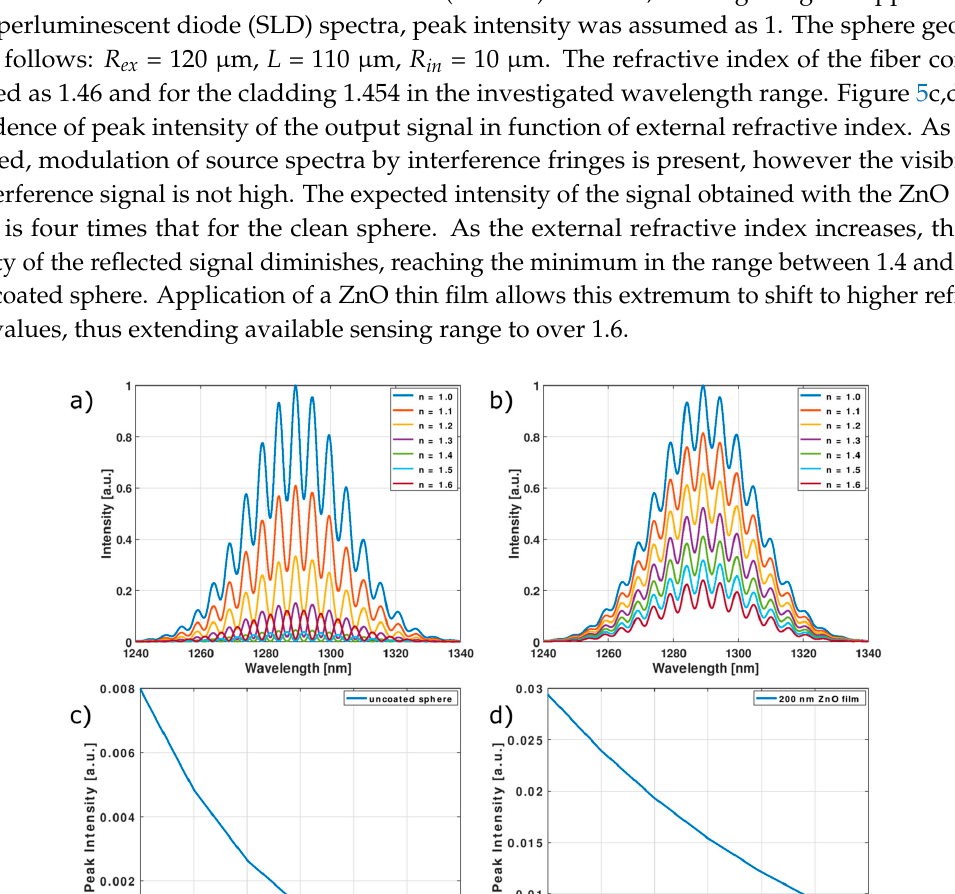
Figure 4. Raman spectra of the ZnO layer deposited on microsphere.